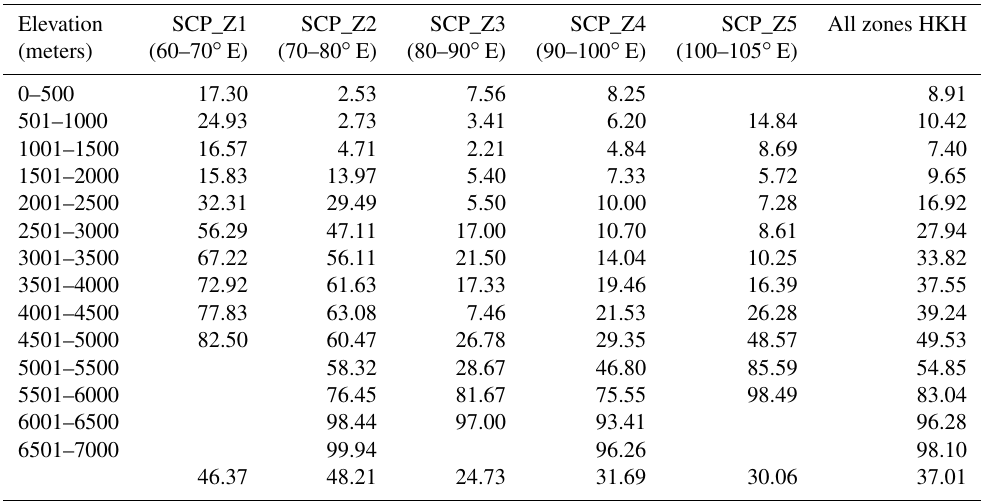
Table 3. Zonal and altitudinal (at 500m intervals) distribution of snow cover (percent) over the HKH region. Note: SCP is the snow cover